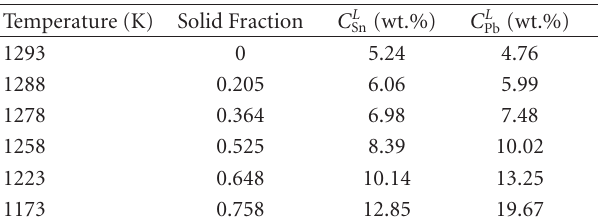
Table 4: Calculated liquid composition during the solidification of the Cu-5Sn-5Pb